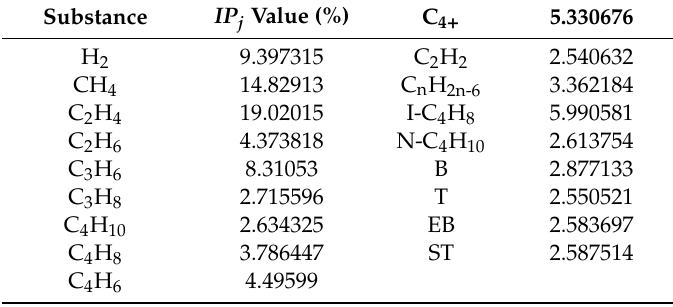
→ IP tr value of each substances in naphtha (1). Table 7. The